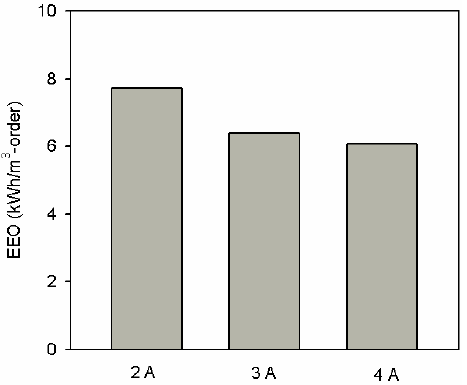
Figure 4. The EEO of NH 4+ -N removal during the electrochemistry treatment of the spent caustic wastewater with varying currents.